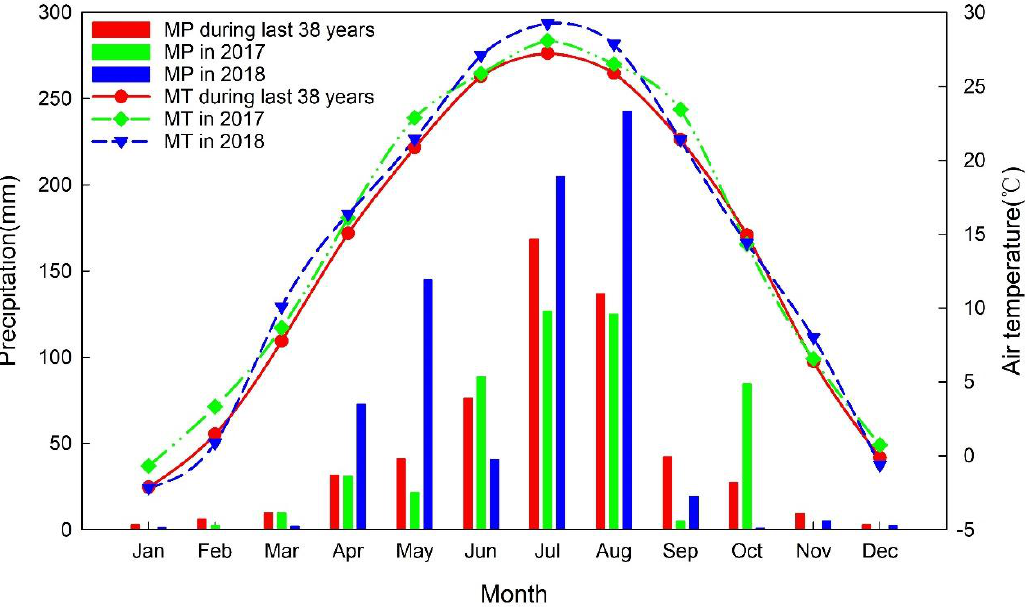
Figure 2. Monthly precipitation and air temperature (MP = mean precipitation, MT = mean air temperature) during 2017, 2018, and the last 38 years (1981–2018) at Wuqiao County, Hebei Province, China.